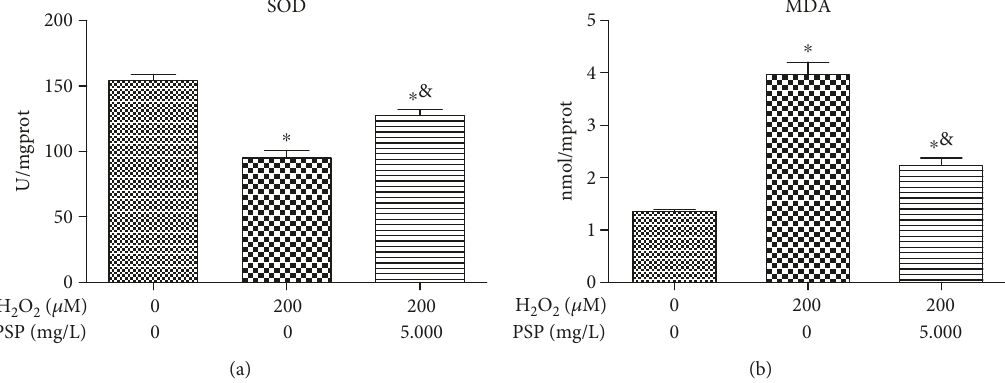
Figure 4: Protective e ff ect of PSP on oxidative stress in rat NPCs. (a) Detection of the intracellular reducing substance SOD. (b) Detection of intracellular oxidation product MDA. ∗ P < 0 05 , compared with the blank group. & P < 0 05 , compared with the H